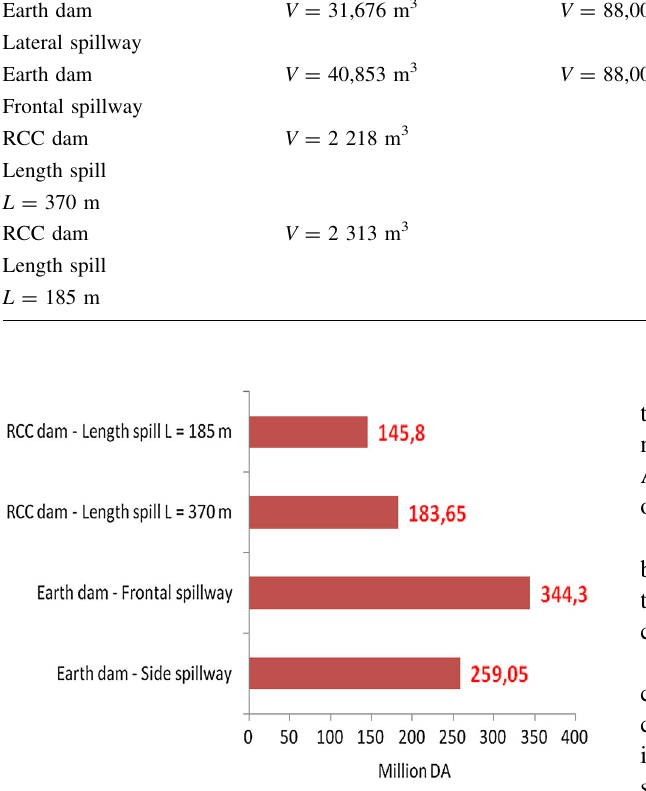
Fig. 3 Financial comparison between design